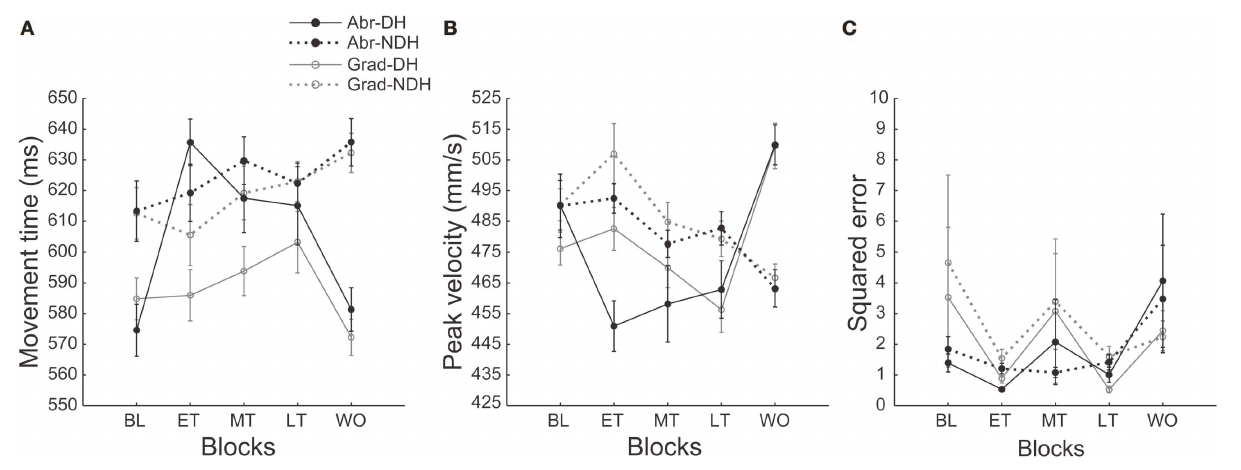
each panel. Filled circles with black lines indicate the abrupt condition (Abr), and open circles with gray lines indicate the gradual condition (Grad). Solid lines indicate the dominant hand (-DH), and dotted lines indicate the non-dominant hand